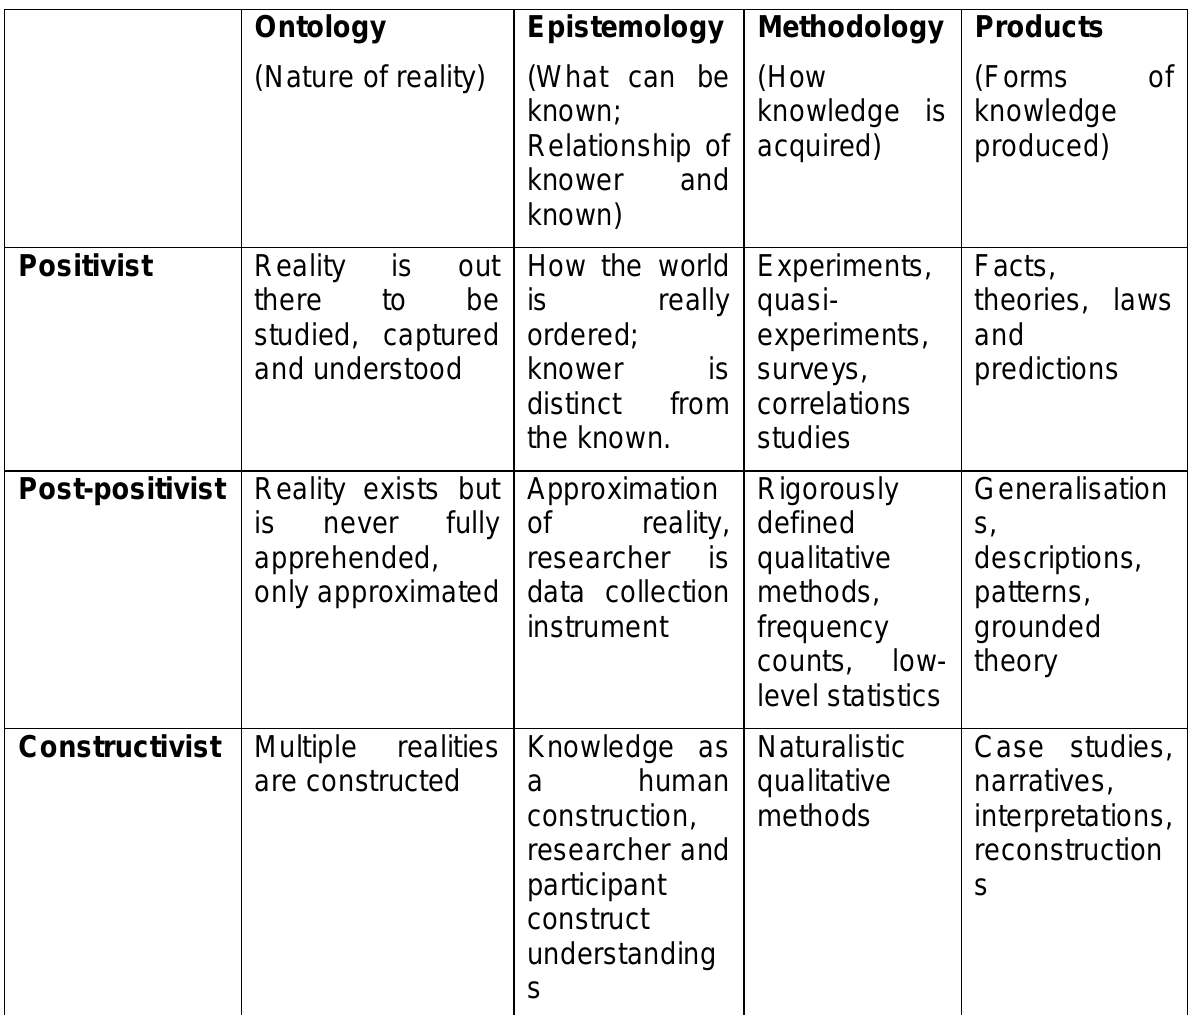
Table 3.1: Research paradigm adapted from Hatch (2002, p,